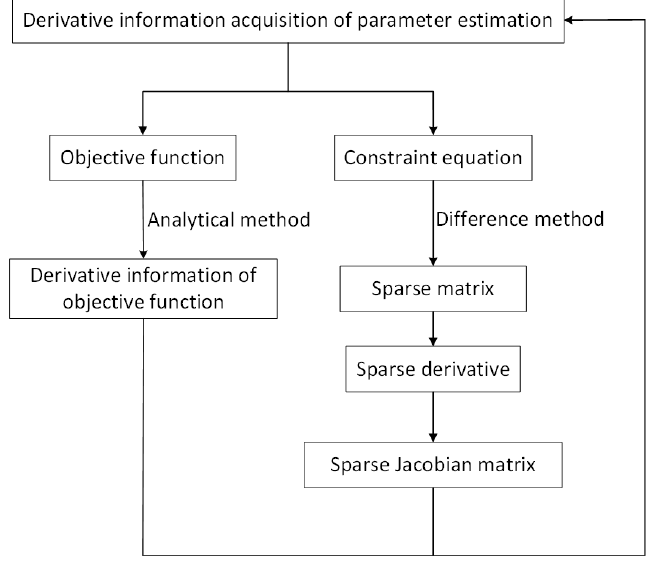
Figure 2. Derivative information acquisition